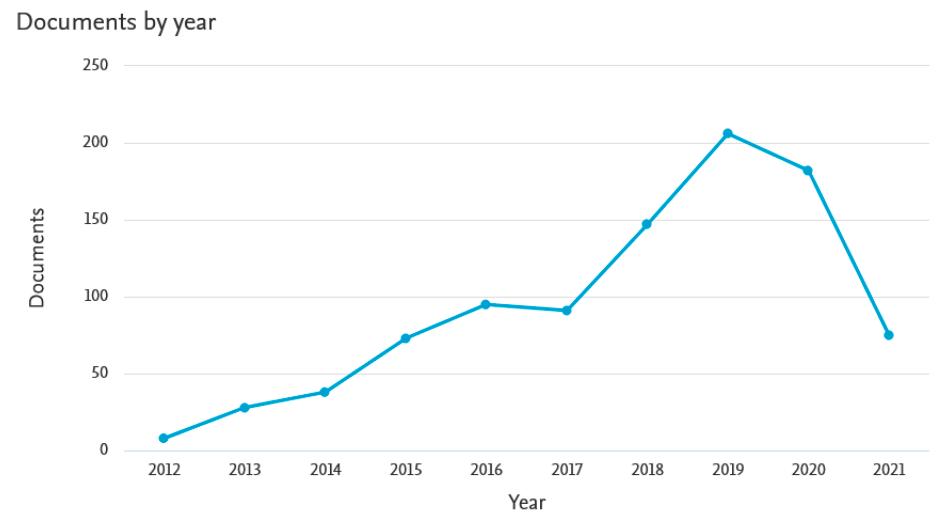
Figure 8. Documents found in Scopus for the “big data mining” key phrase by year of publication.